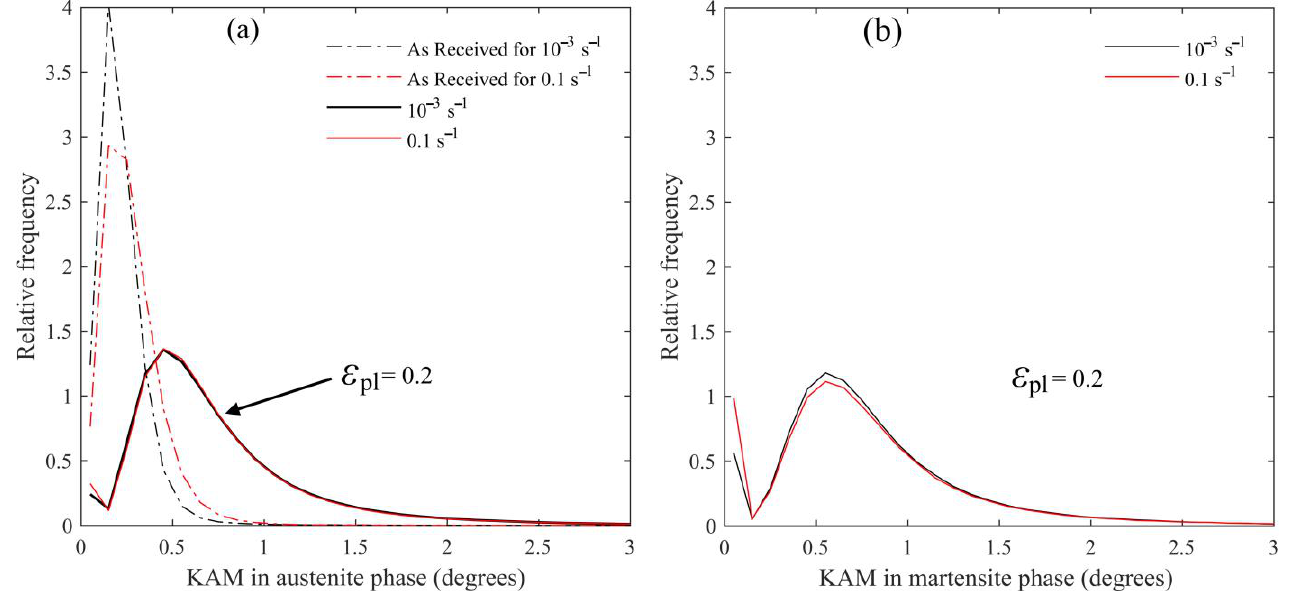
Figure 6. KAM distributions of ( a ) austenite and ( b ) martensite phases at two different strain